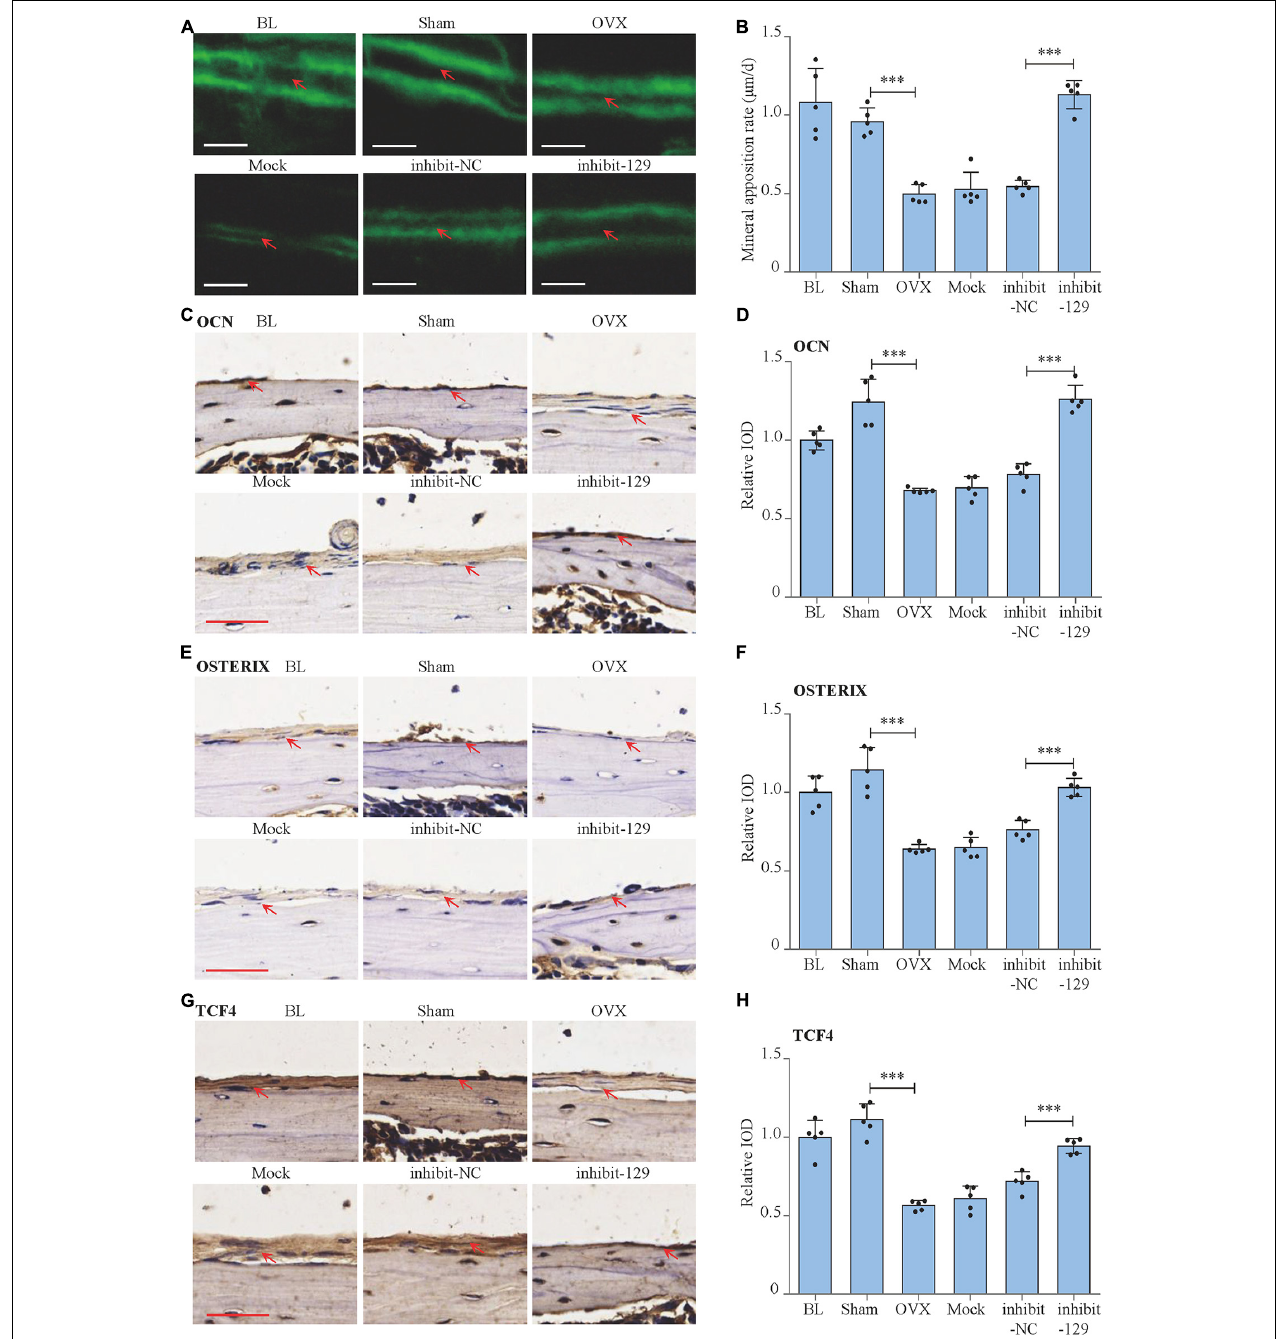
FIGURE 6 | Rescue effect of miR-129-5p inhibitor on postmenopausal osteoporosis. (A) Representative images showing calvarial mineral apposition rate of C57BL/6 mice after OVX and inhibitor-129-5p treatment. Scale bar: 10 µ m. BL (baseline): sacrifice before RNA treatment. Sham: sham OVX operation group. OVX: OVX group. Mock: transfection reagent control group. inhibit-NC: inhibitor-NC–treated group. inhibit-129: inhibitor-129-5p–treated group. (B) Calvarial mineral apposition rates of C57BL/6 mice after OVX and inhibitor-129-5p treatment (mean ± SD, ∗∗∗ P < 0.001). (C) Expression of OCN in calvarial tissues of C57BL/6 mice after OVX and inhibitor-129-5p treatment, as detected by immunohistochemical staining. Scale bar: 50 µ m. (D) Quantification of relative integrated optical density (IOD) values of OCN immunostaining using Image-Pro Plus 6.0 software (mean ± SD, ∗∗∗ P < 0.001). (E) Expression of OXTERIX in calvarial tissues of C57BL/6 mice after OVX and inhibitor-129-5p treatment, as detected by immunohistochemical staining. Scale bar: 50 µ m. (F) Quantification of relative IOD values of OXTERIX immunostaining using Image-Pro Plus 6.0 software (mean ± SD, ∗∗∗ P < 0.001). (G) Expression of RUNX2 in calvarial tissues of C57BL/6 mice after OVX and inhibitor-129-5p treatment, as detected by immunohistochemical staining. Scale bar: 50 µ m. (H) Quantification of relative IOD values of RUNX2 immunostaining using Image-Pro Plus 6.0 software (mean ± SD, ∗∗∗ P < 0.001).